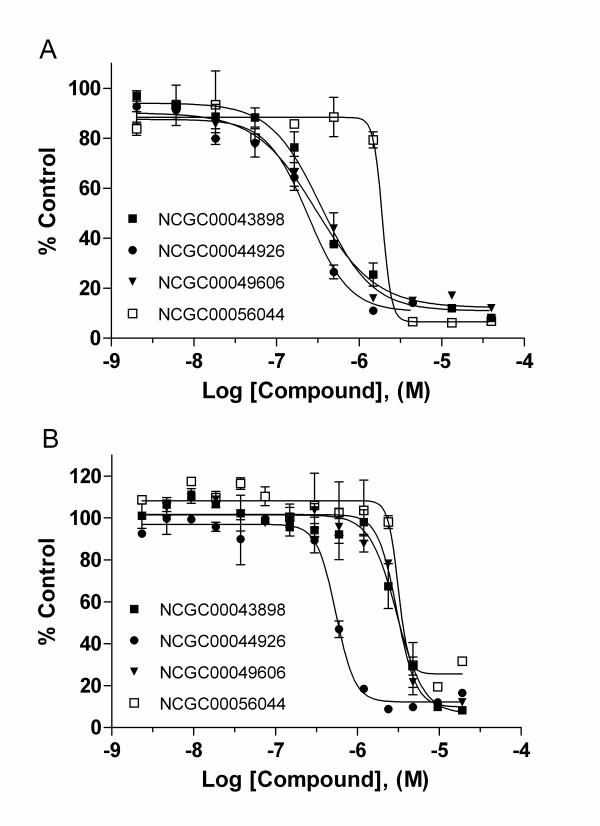
Effect of four novel inhibitors on HIF-1 signaling pathway. Inhibition of HIF-1 mediated β-lactamase activity in HRE-bla ME-180 cells by various concentrations of NCGC00043898, NCGC00044926, NCGC00049606 and NCGC00056044 in the presence of 1% oxygen (A) and 60 μM CoCl2 (B). The data are displayed as the percentage of control. Representative values are from a single experiment performed in duplicate. Data are expressed as mean ± SD.